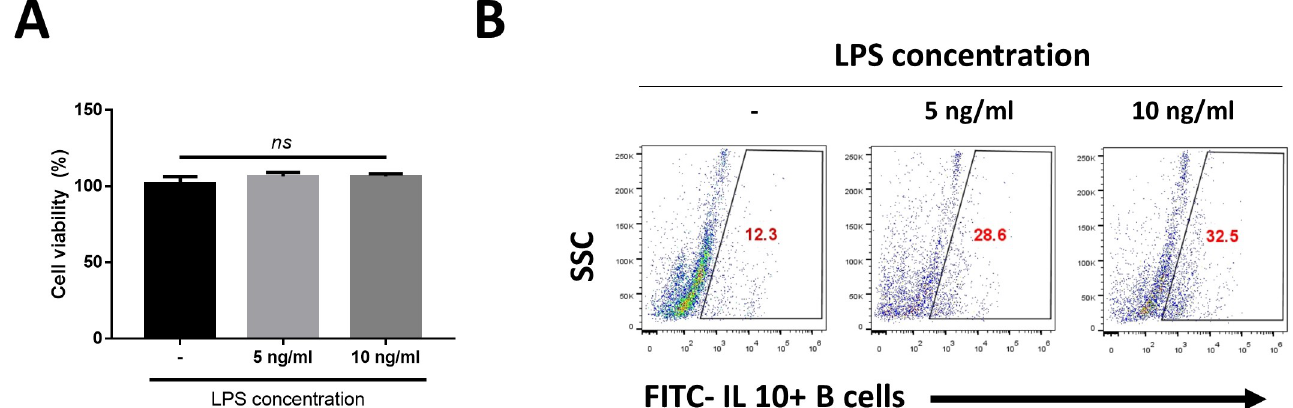
Fig 1. Characterization of B cell isolated from canine peripheral blood mononuclear cells. (A) Cell viability assay. Cell viability of B cells according to the LPS concentration gradient was confirmed through CCK-8 analysis. (B) Through flow cytometry, the degree of increase in B cells expressing IL-10 was confirmed. Representative of three independent experiments with similar results. Data are shown as mean ± standard deviation of three independent experiments ( ns = Not Statistically Significant by one-way ANOVA analysis).